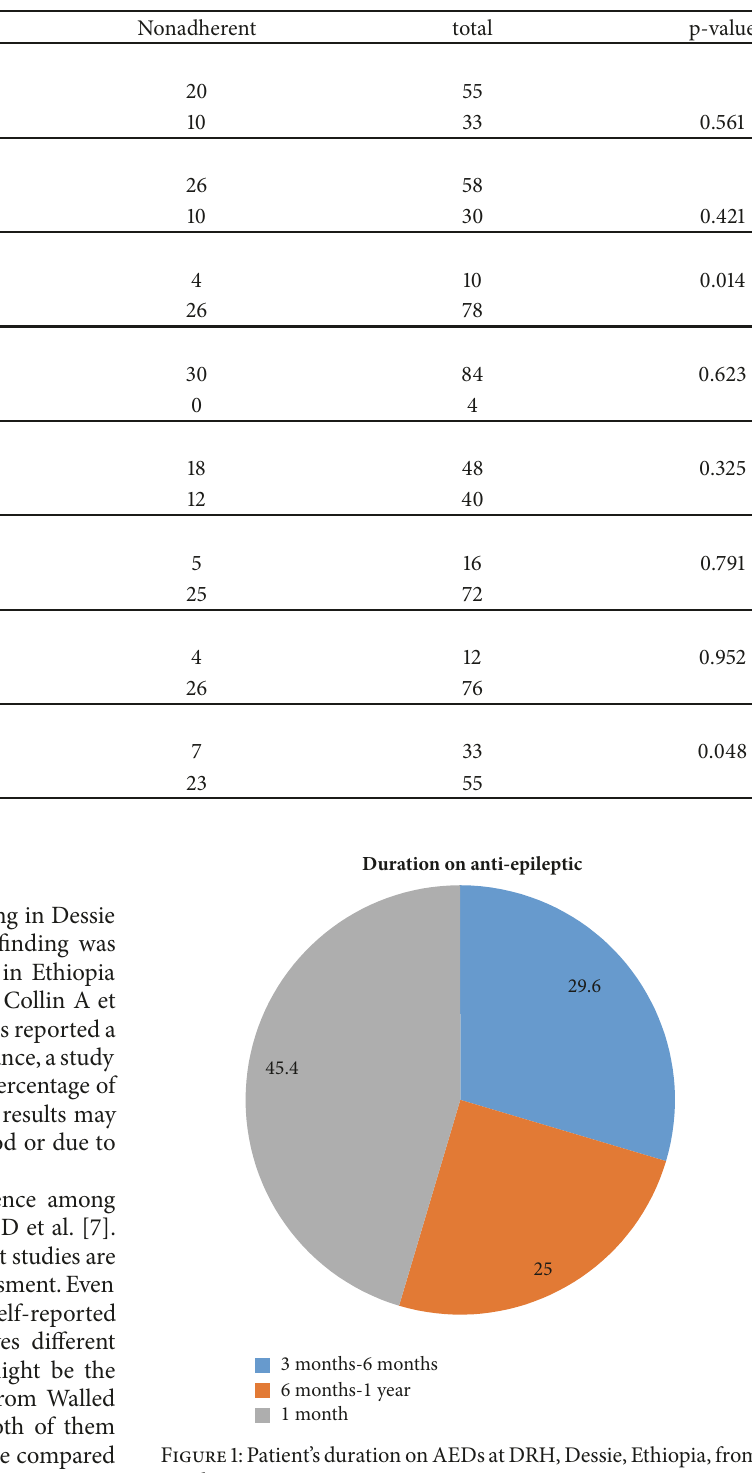
Table 4: Association of Adherence with possible determinants of adherence at DRH, Dessie, Ethiopia, from April to June 2015.